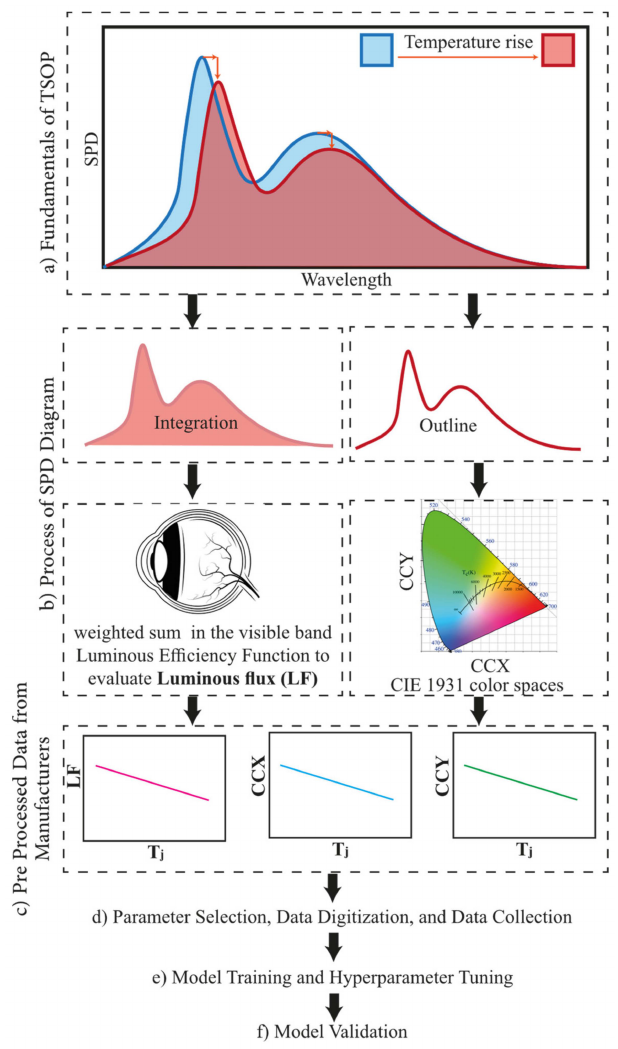
Figure 1. Road map illustration of the current study which provides ( a ) basic behavior of the spectral power distribution (SPD) of a WLED by the temperature rise of the junction, ( b ) process of the SPD diagram for luminous flux (LF), and correlated color temperature (CCT) determination. Based on this processed information, manufacturers provide ( c ) postprocessed data for the determination of the temperature sensitivity of the chip. ( d ) Provided data from manufacturers can be digitized and collected for ( e ) ML model training and tuning. ( f ) Model validation for the accuracy of the universal